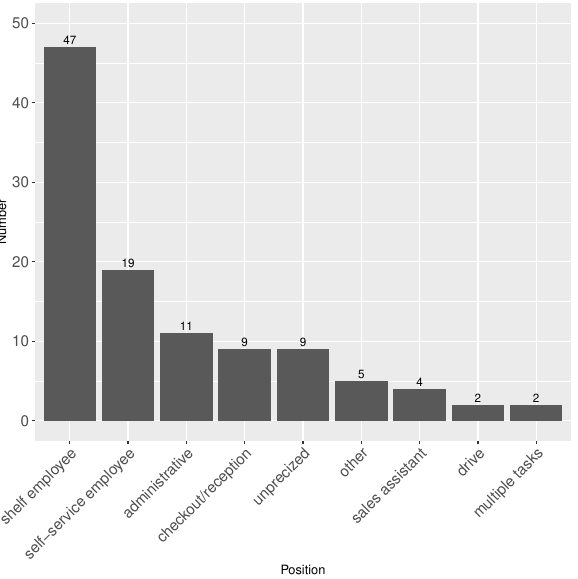
Figure 1. Positions of employees who reported a decrease in work load ( n = 109, one missing